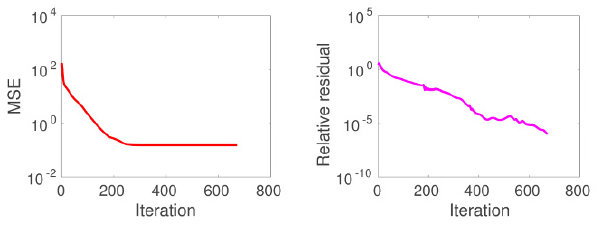
Fig. 1 MSE vs. relative residual during CG iterations, for the “Sombrero” dataset. Although arbitrary relative accuracy can be reached, it is not useful to go beyond a 10 − 3 residual, since such refinements have very small impact on the quality of the reconstruction, as shown by the MSE graph. Similar results were